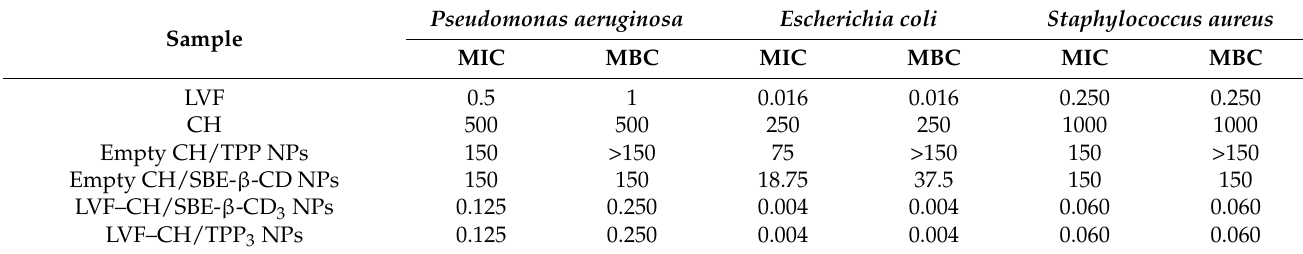
Table 6. Minimum inhibitory concentration (MIC) and minimum bactericidal concentration (MBC) values ( µ g/mL) of free LVF, free CH, empty NPs, and LVF-loaded NPs against Gram-negative and Gram-positive bacteria.